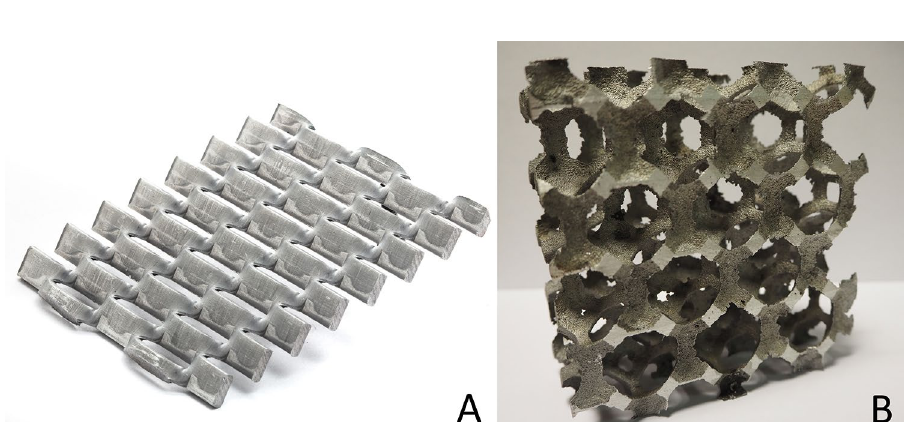
Fig. 3 Metal grids. A Small round holes, porosity of 48%, hole size of 10 mm and dis- tance of 14 mm between the holes, thickness of 1.5 mm; B large round holes, porosity of 49.8%, hole size of 20 mm and distance of 27 mm between the holes, thickness of 2 mm; C square holes, porosity of 69.4%, hole size of 10 mm and distance of 12 mm between the holes, thickness of 1.5 mm